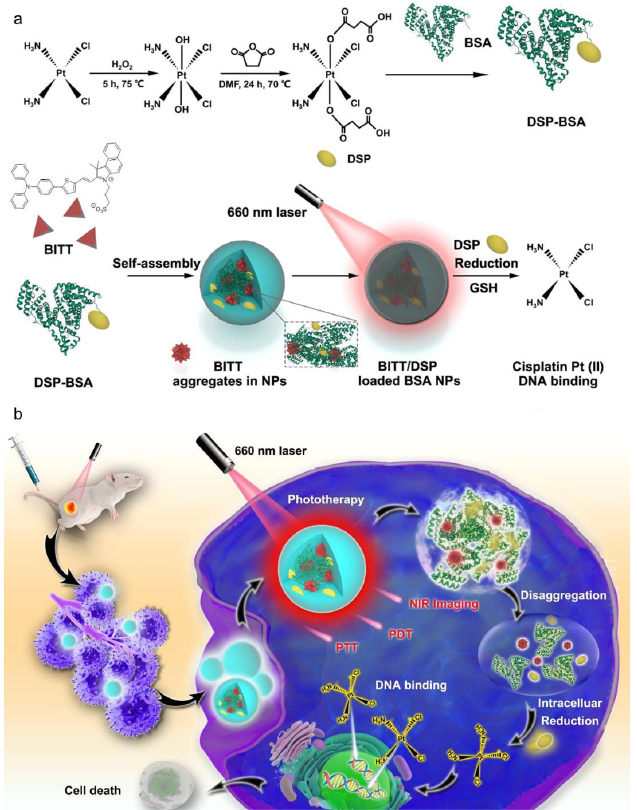
Figure 5. ( a ) Schematic illustrations of the synthesis and preparation of BITT@BSA−DSP NPs. ( b ) Schematic for the NIR-II fluorescence imaging-guided phototherapies of bladder cancer (Reprinted with permission from Ref. [97]. Copyright 2022, American Chemical Society).